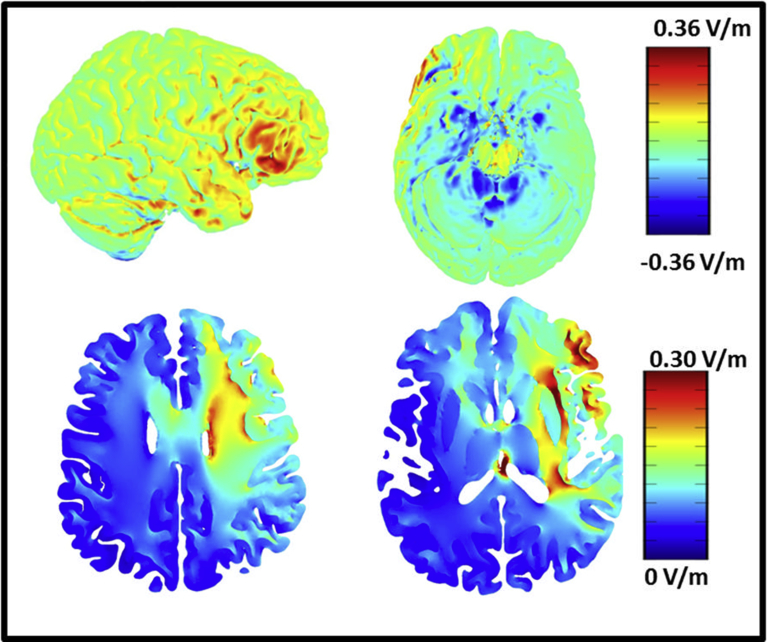
Modeled current distribution of right frontal tDCS montage used during MBT. Modeled current distribution of F10 (anode) and contralateral upper bicep (cathode) placement (Bikson et al., 2012; courtesy of Alexander David and Marom Bikson, City College New York).